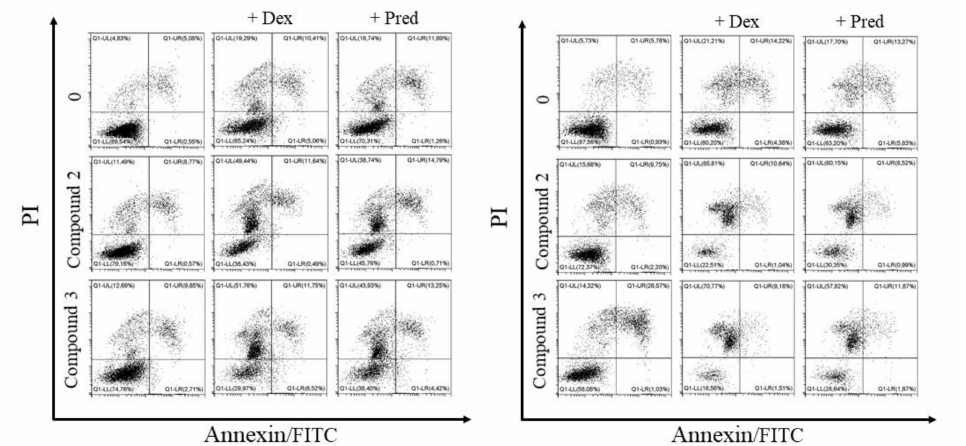
Figure 6. Synergistic effect of flavanone-derived γ -oxa- ε -lactones (3.125 µ g/mL) combined with dexamethasone (Dex) or prednisolone (Pred) (2.5 µ g/mL) in CLBL-1 ( left ) and CLB70 ( right ) in annexin V and propidium iodide double staining. Visible strong induction of necrotic instead of apoptotic cell death after the use of the lactone and corticoid